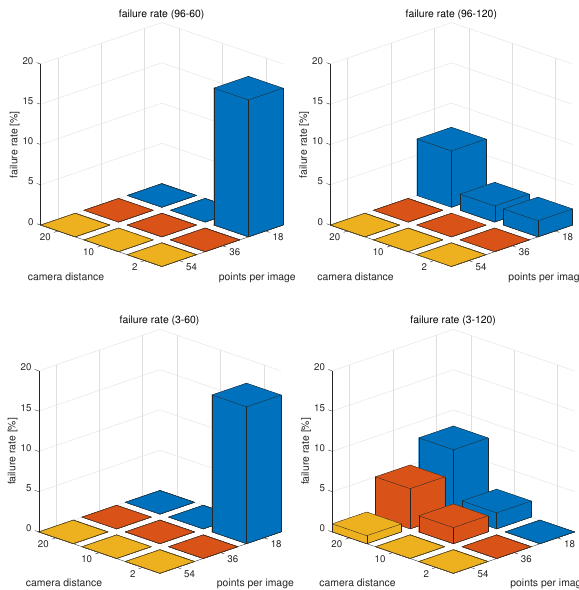
Figure 5. Mean and median RMS error vs percentage of outliers ( m = 16 , n = 96 , d = 10 , p = 36 ). The RMS error is in percentage with reference to points distributed on a unit sphere.